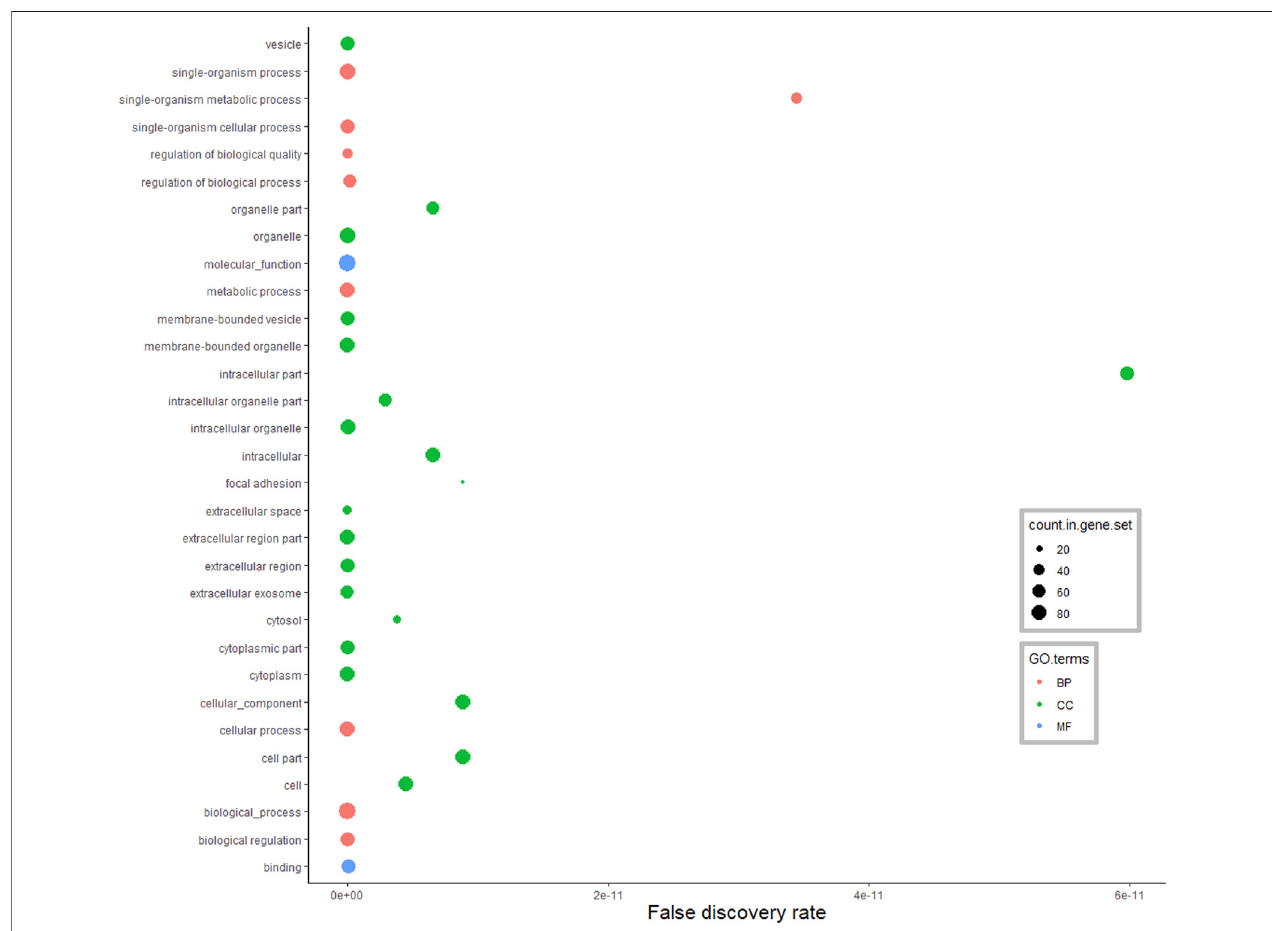
FIGURE 4 | Functional classi fi cation of differentially abundant proteins in the pituitary between pre-versus postpubertal heifers. Only highly signi fi cant GO terms were shown (FDR < 1.0E − 10).